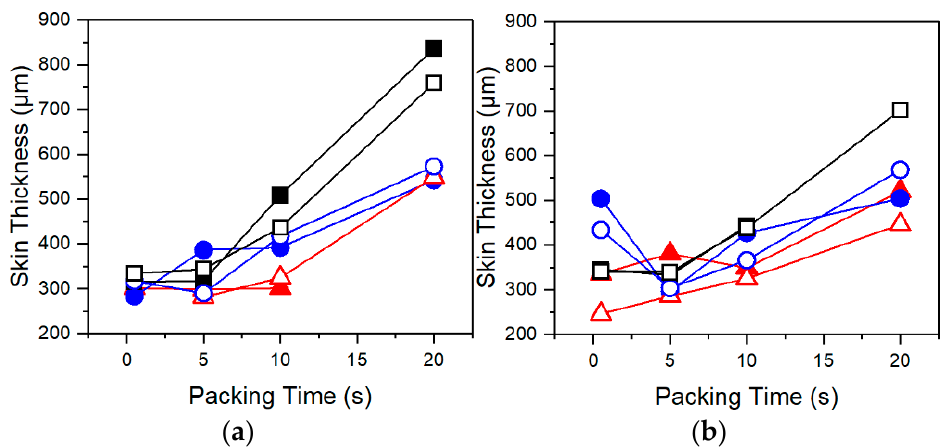
Figure 6. Skin thickness of Resin A (red triangles), Resin B (blue circles), and Resin C (black squares) samples foamed using ( a ) AV CBA and ( b ) UC CBA under various packing times. Closed and open symbols indicate 1 wt% and 2 wt% CBA, respectively.